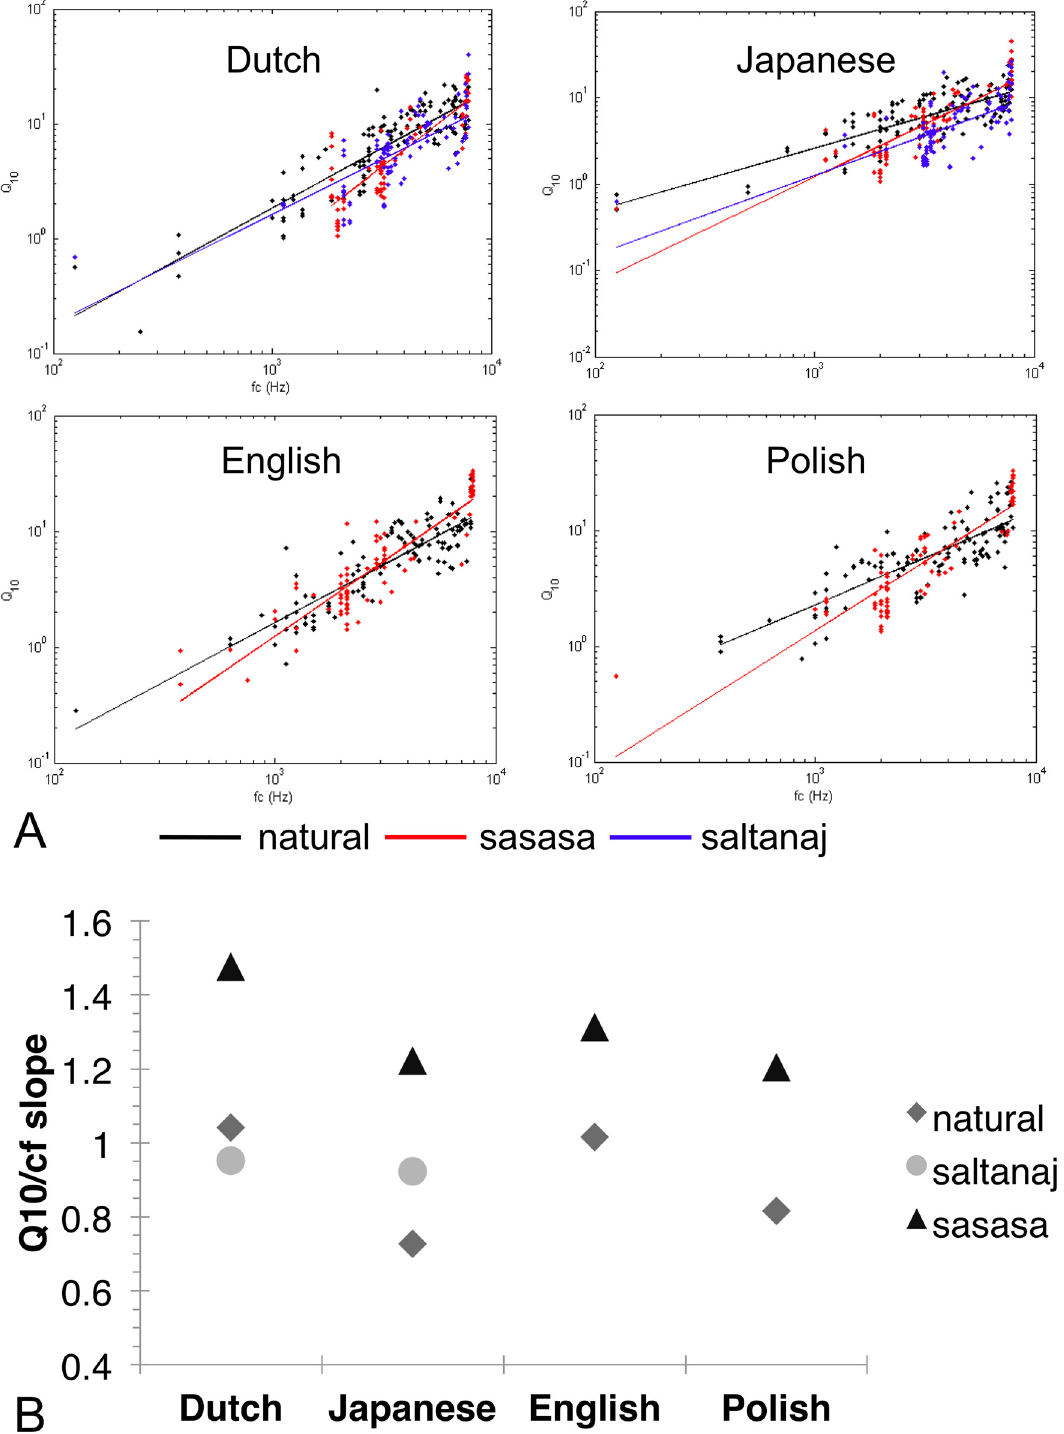
Fig 4. The Results of Analysis 2. A. The sharpness of the derived filter populations as a function of center frequency for Dutch, Japanese, English and Polish natural, saltanaj and sasasa stimuli. B. The values of the slopes as a function of language and transformation.